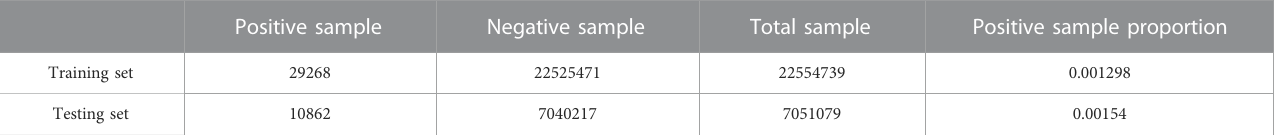
TABLE 4 Sample number information of training set and testing set.